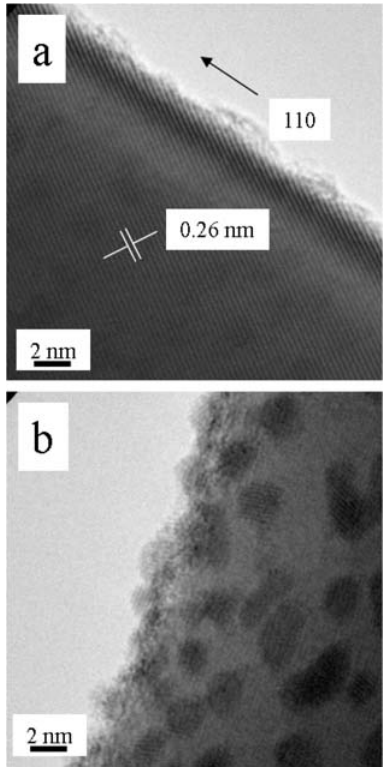
Figure 18. HRTEM image of Pd deposited on SnO particles are relatively uniform in size and shape. The very high magnification image shows the single-crystal structure of the deposited